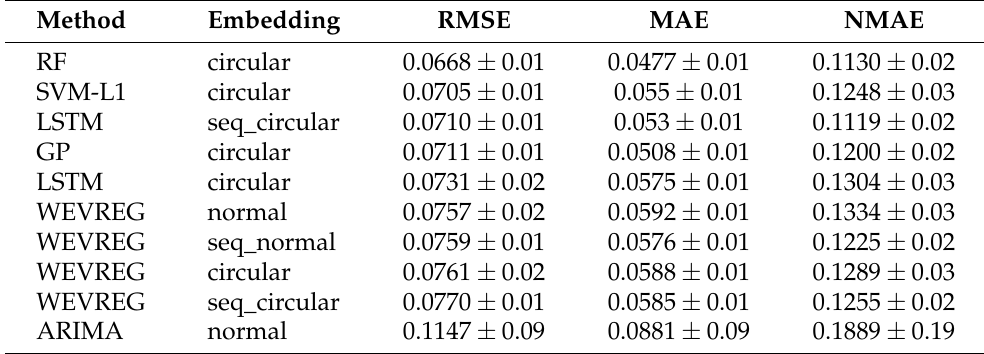
Table 8. Stores sales prediction performance.